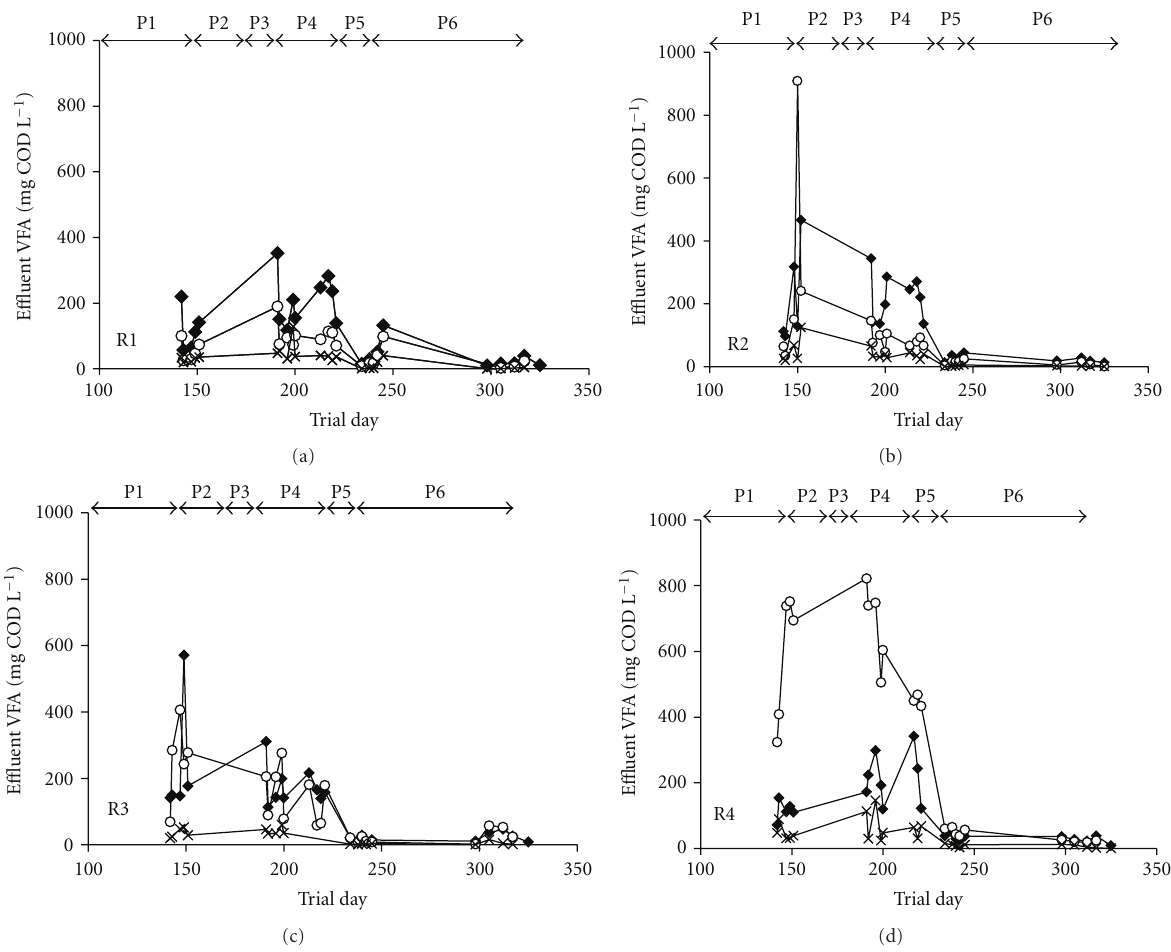
Figure 4: E ffl uent VFA concentrations of R1–R4: acetic acid ( (cid:2) ); propionic acid ( (cid:6) ); butyric acid (-x-). R1: 37 ◦ C TCE-supplemented; R2: 37 ◦ C control; R3: 15 ◦ C TCE-supplemented; R4: 15 ◦ C